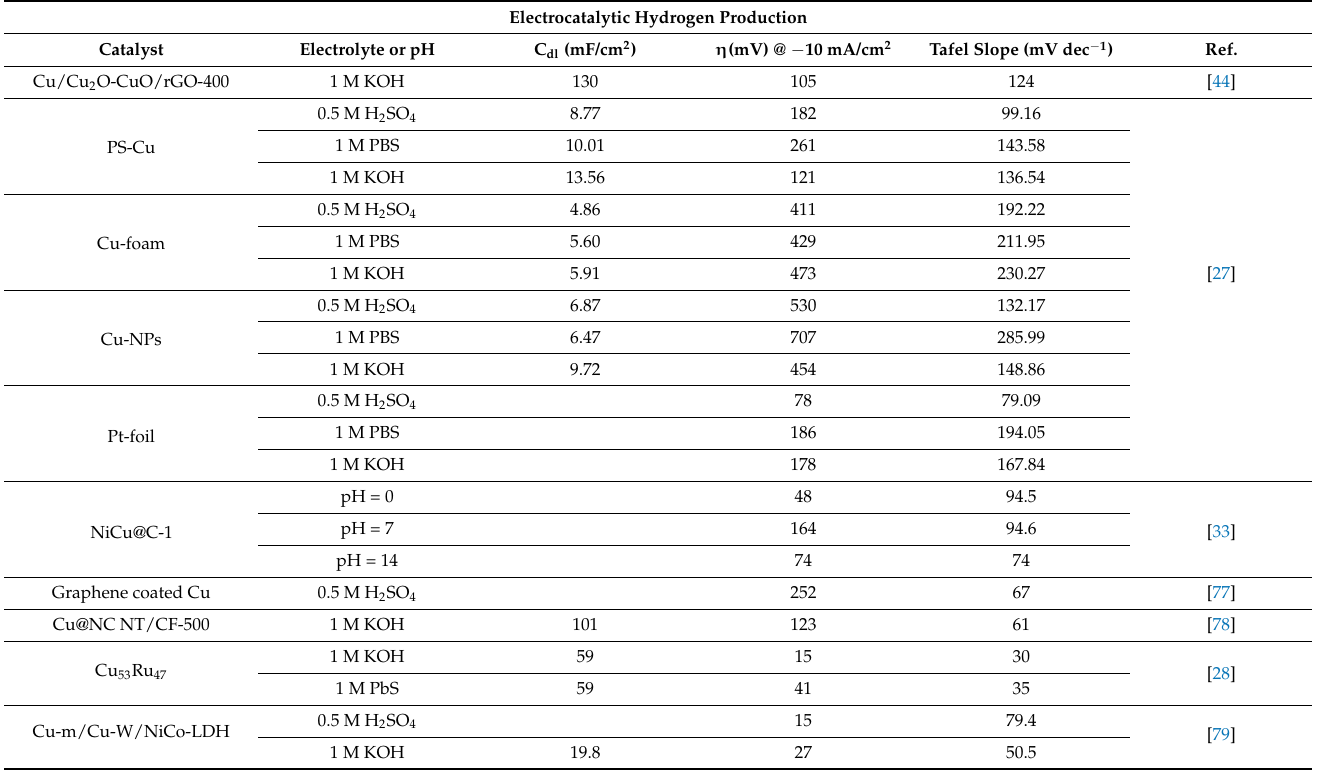
Table 3. Summary of Electrocatalytic Parameters, related to Hydrogen Evolution Reaction, for Cu-based